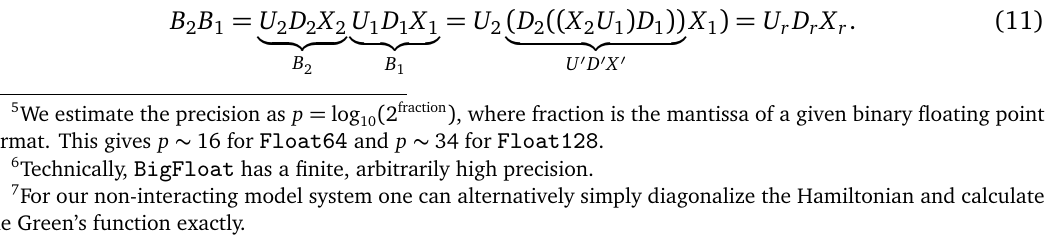
Numerical instabilities due to finite machine precision arising in the calculation of the time slice matrix chain product B ferent lines represent logarithmic singular values as observed in naive (green) and arbitrary precision computations (orange) for a N = 4 system. Due to (quasi) degen- eracies only 5 out of 8 singular values are visually distinguishable. The dashed line (grey) indicates the expected floating point accuracy 5